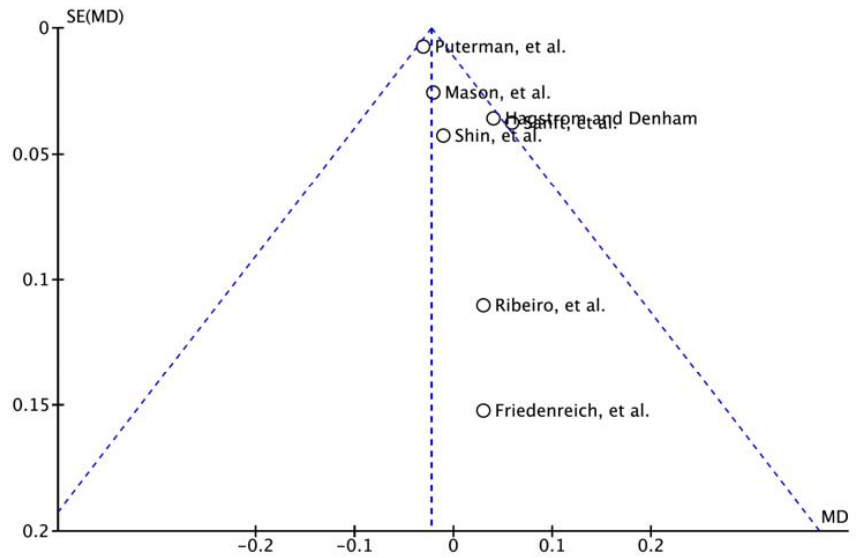
Figure 5. Funnel plot of